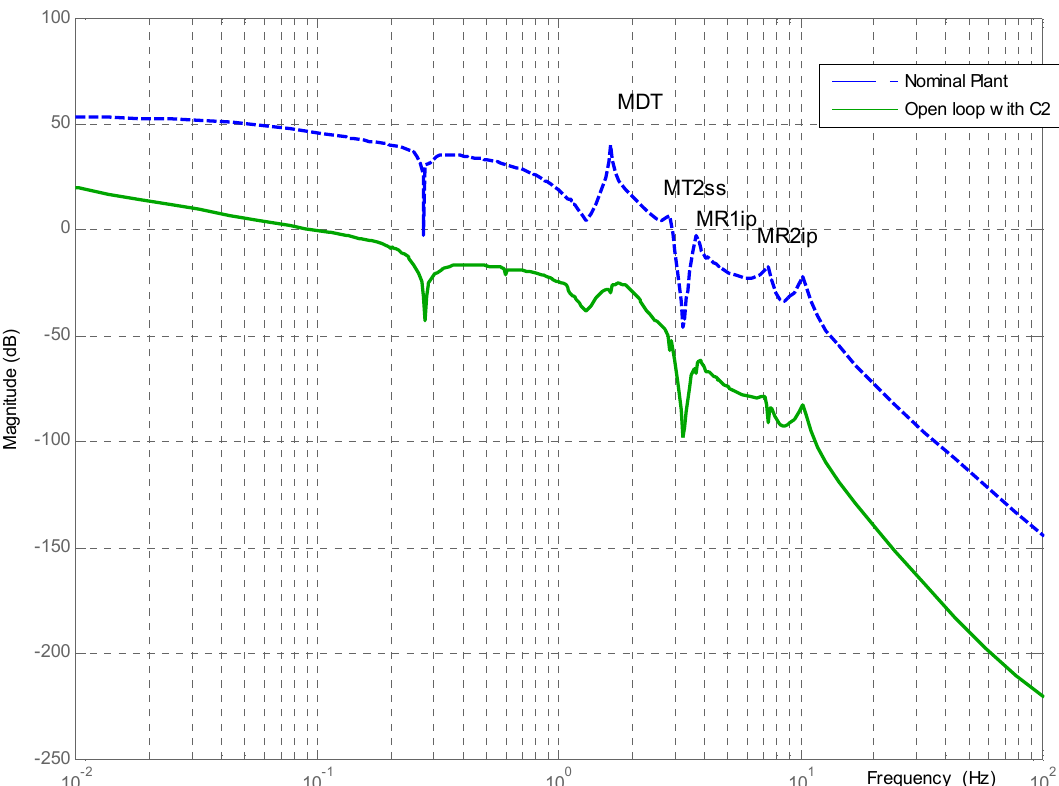
Figure 12. Effect of the pitch controller notch filter in open